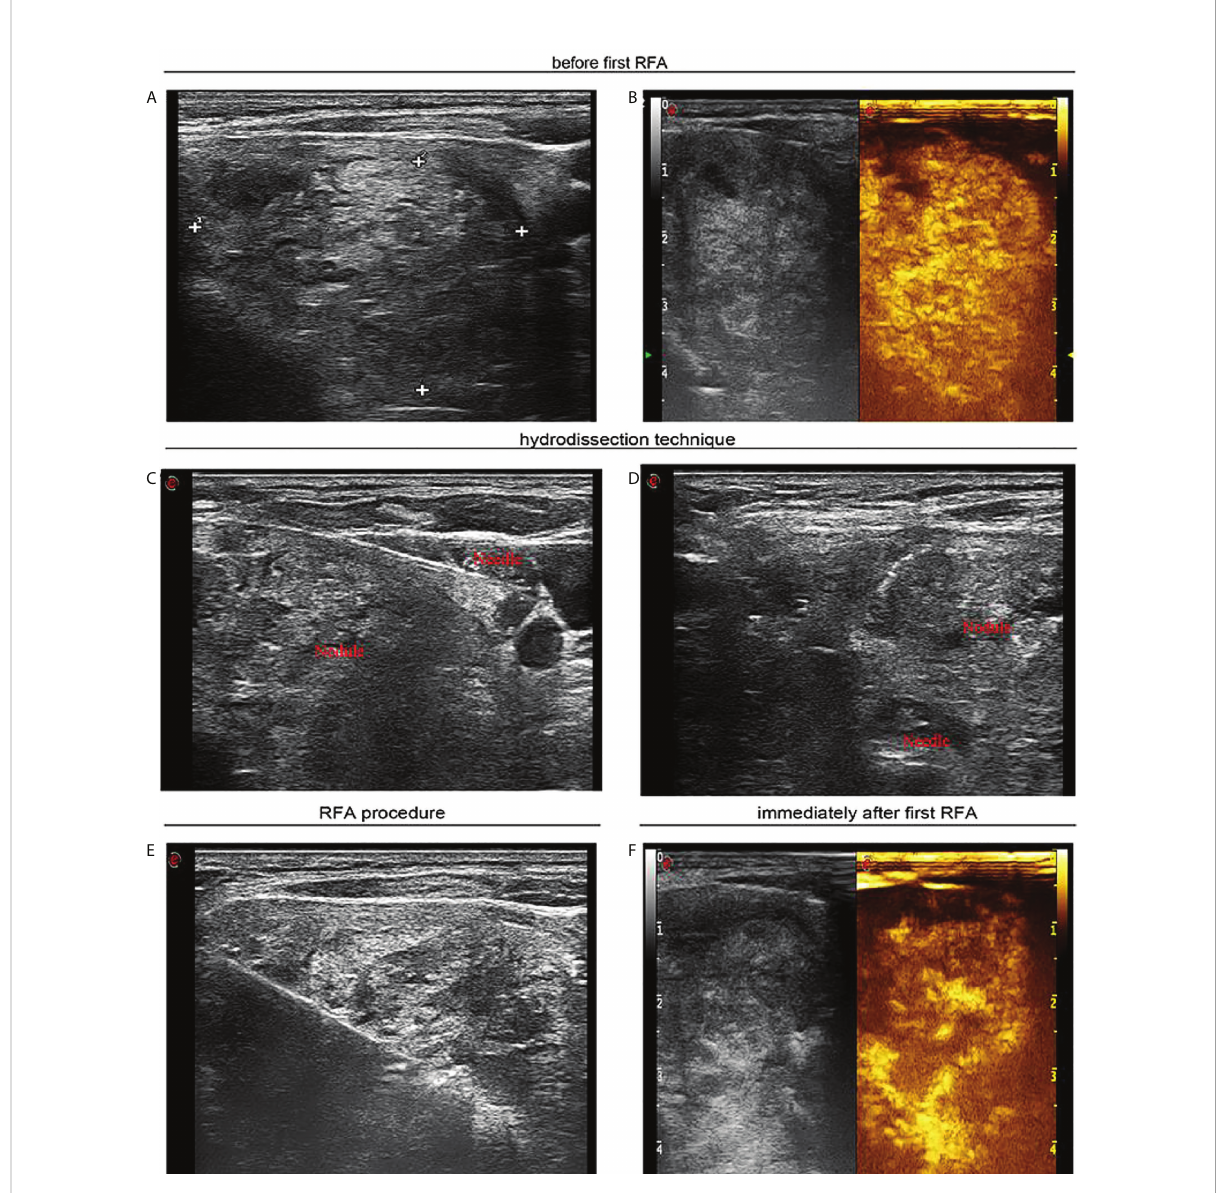
FIGURE 2 A 55-year-old woman with a large solid thyroid nodule extending to subclavian region received ultrasound-guided sequential radiofrequency ablation treatment. (A) Before the fi rst radiofrequency ablation ultrasound image in transverse view unveils a solid thyroid nodule of 4.2 × 3.9 cm that extended to the subclavian region. (B) Contrast-enhanced ultrasound manifests hyperenhancement in large thyroid nodule. (C) Ultrasound image in transverse view con fi rms that sterile water has reached between thyroid tissue and carotid artery. (D) Ultrasound image in transverse view reveals that sterile water has reached between thyroid tissue and trachea. (E) Ultrasound image in transverse view shows that percutaneous radiofrequency ablation was implemented utilizing the moving shot technique. (F) Contrast-enhanced ultrasound indicates residual enhancement in partial thyroid nodule extending below clavicle immediately after the fi rst radiofrequency